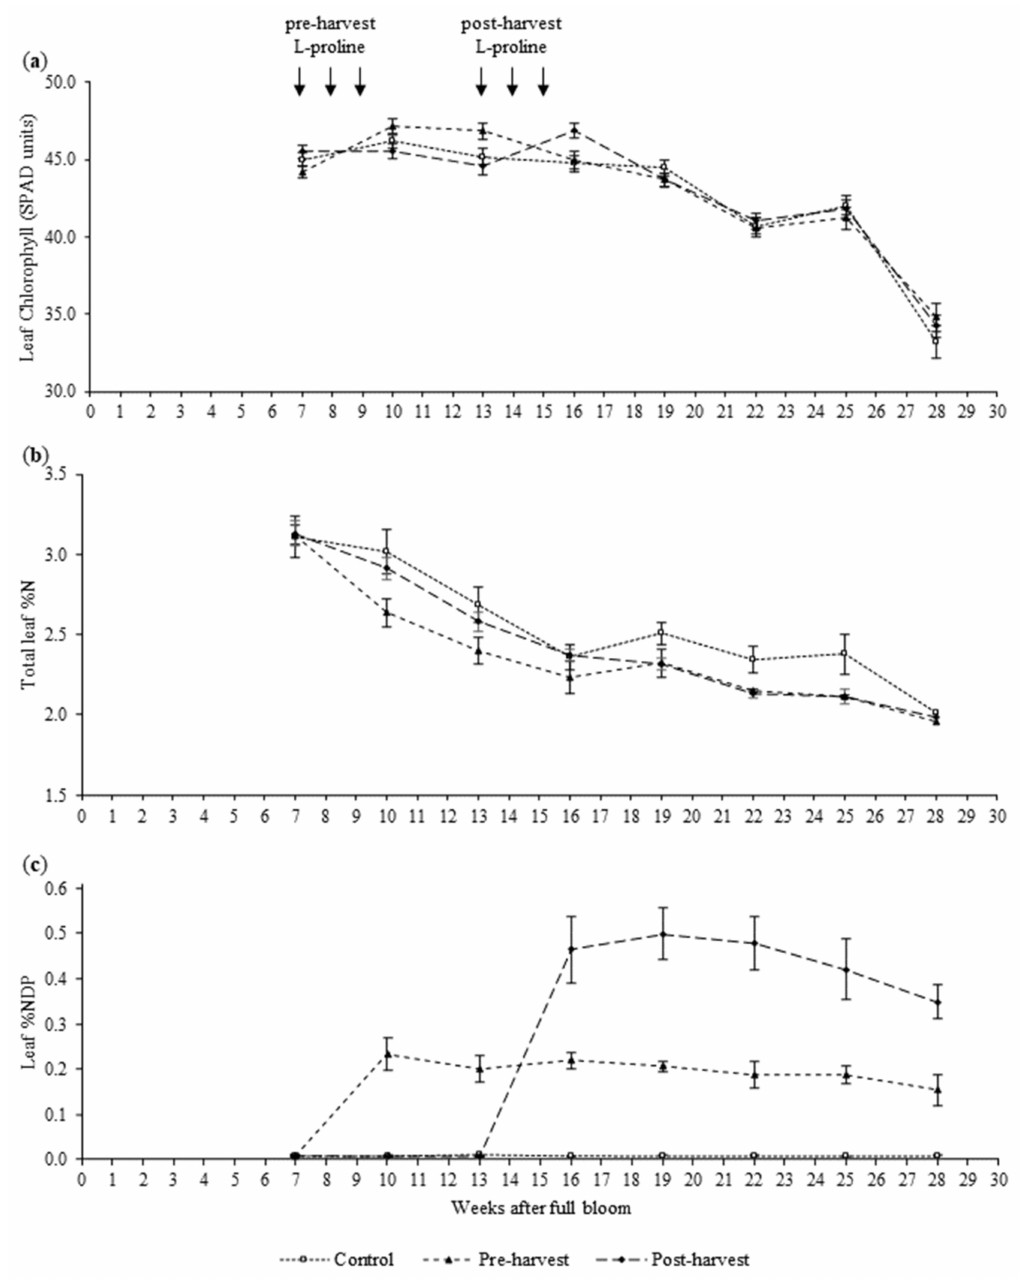
Figure 1. ( a ) Chlorophyll estimates (SPAD units; n = 40), ( b ) total leaf N content (%N; n = 4), and ( c ) N derived from L-proline (%NDP; n = 4) from initial sampling prior to the first L-proline application (7 WAFB) until leaf senescence (28 WAFB). Pre- and post-harvest treatments were applied weekly from 7 to 9 WAFB, and 13 to 15 WAFB, respectively. Error bars represent ± standard error of the means